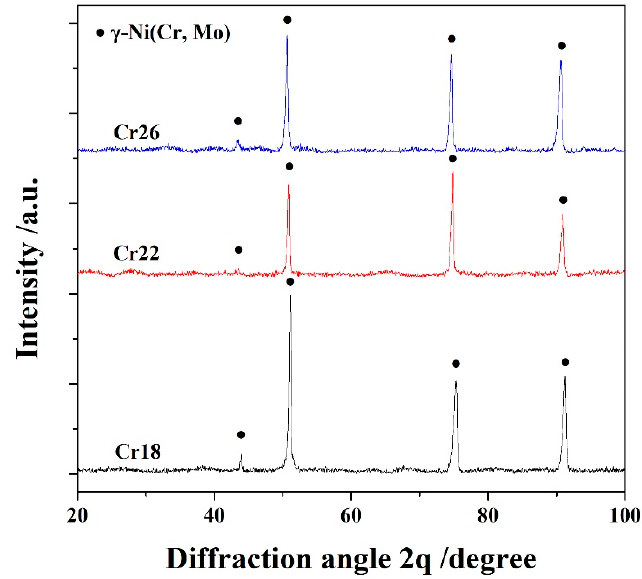
Figure 1. XRD patterns of laser cladding Ni-Cr-Mo alloy coatings.